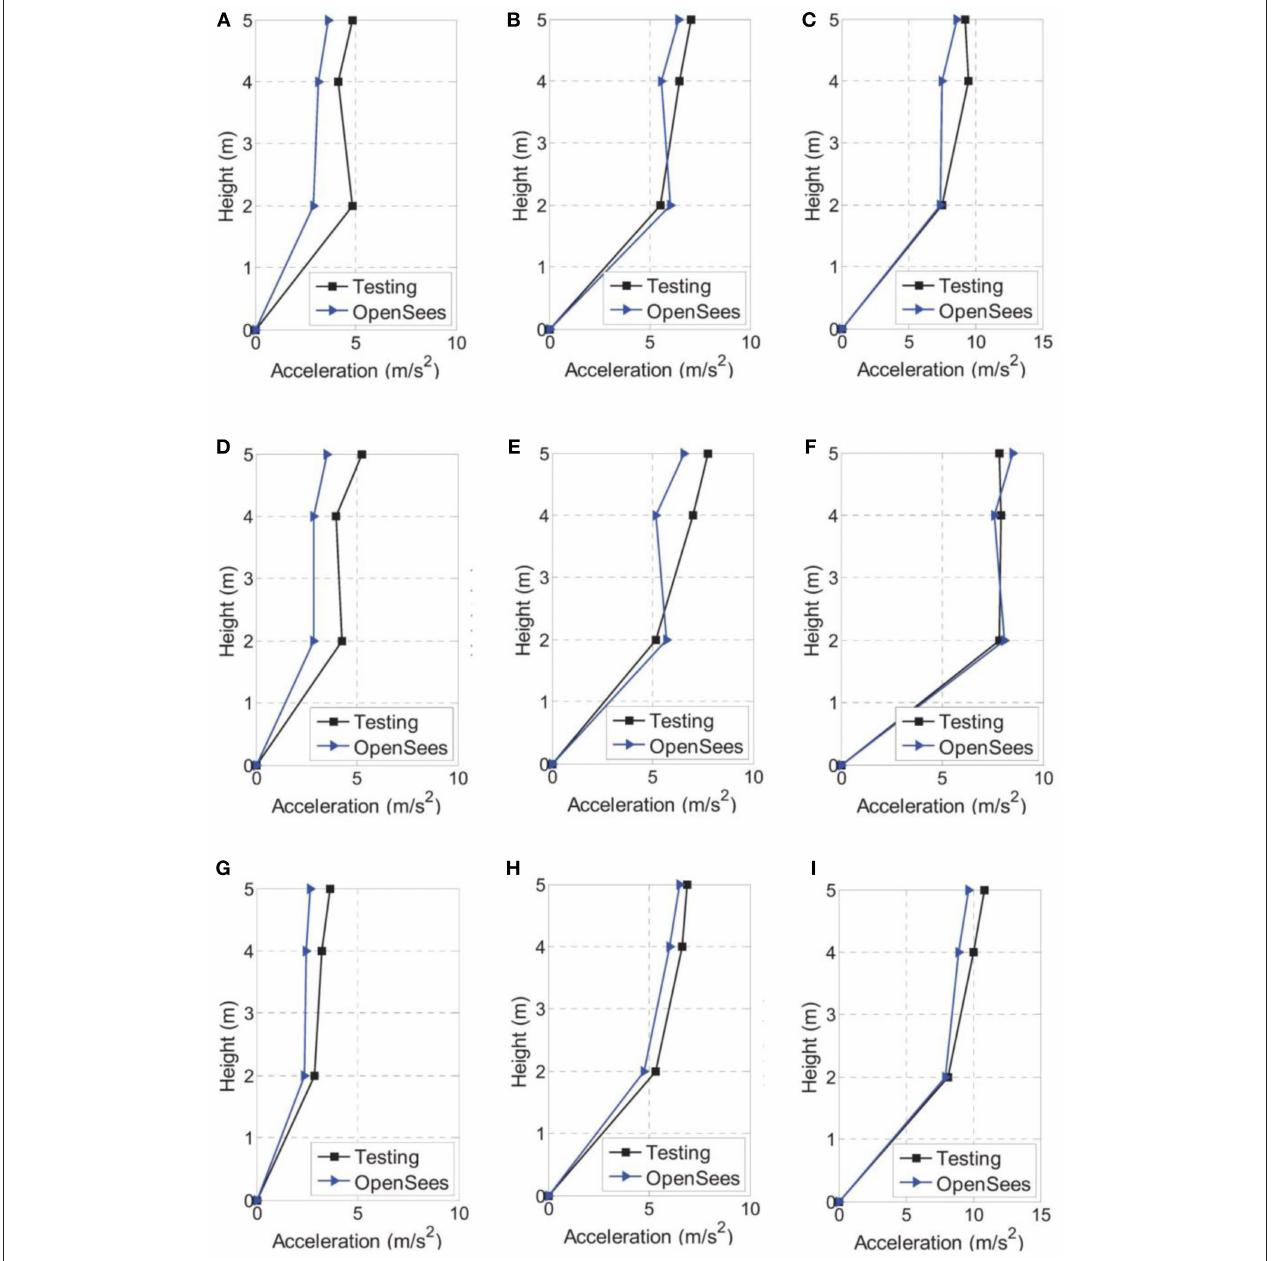
FIGURE 12 | Peak floor acceleration response comparison under input of (A) El Centro-0.2g, (B) El Centro-0.4g, (C) El Centro-0.6g, (D) Taft-0.2g, (E) Taft-0.4g, (F) Taft-0.6g, (G) AW-0.2g, (H) AW-0.4g, and (I) AW-0.6g.